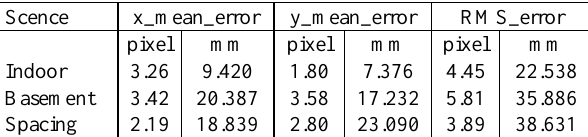
Table 1. Calibration errors of three